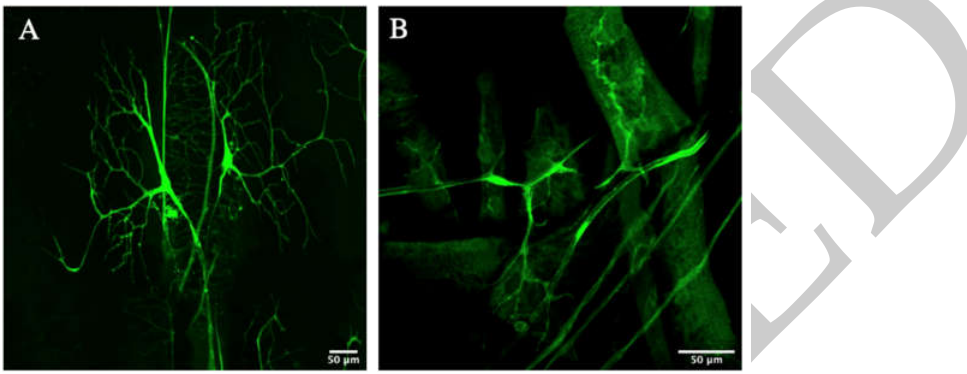
Figure 3. Branching morphogenesis of mutants from alternative stock. ( A ) and ( B ) represent the experimental terminal cells of heat-killed larvae using an alternative stock of fruit flies. A rescue experiment was then performed using the samples in Figure 3 to demon- strate the sufficiency of Zipper in branching for D. melanogaster . These samples with the addition of Zipper are demonstrated in Figure 4. As shown, the fruit flies with rescued genotypes demonstrated similar phenotypes with wild-type fruit flies.